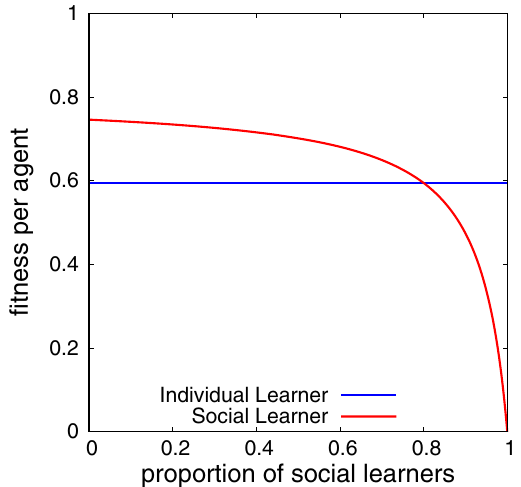
Figure 2. Plots of w I and w S . Parameters: N = 10, q C = 0.2, q I = 0.3, q O =